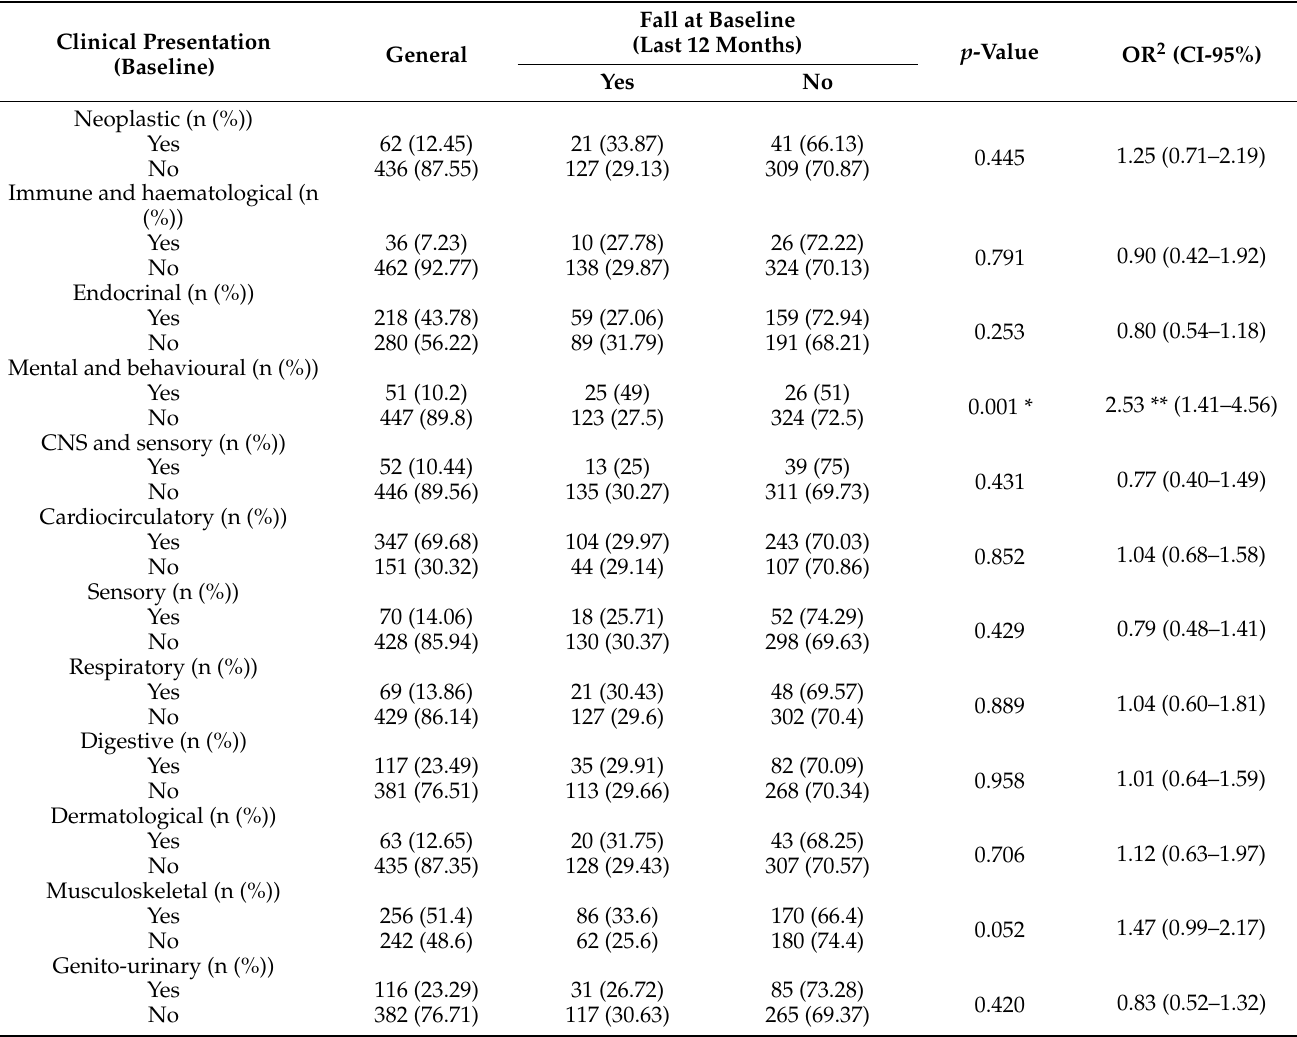
Table 5. Relationship between falls at baseline and clinical